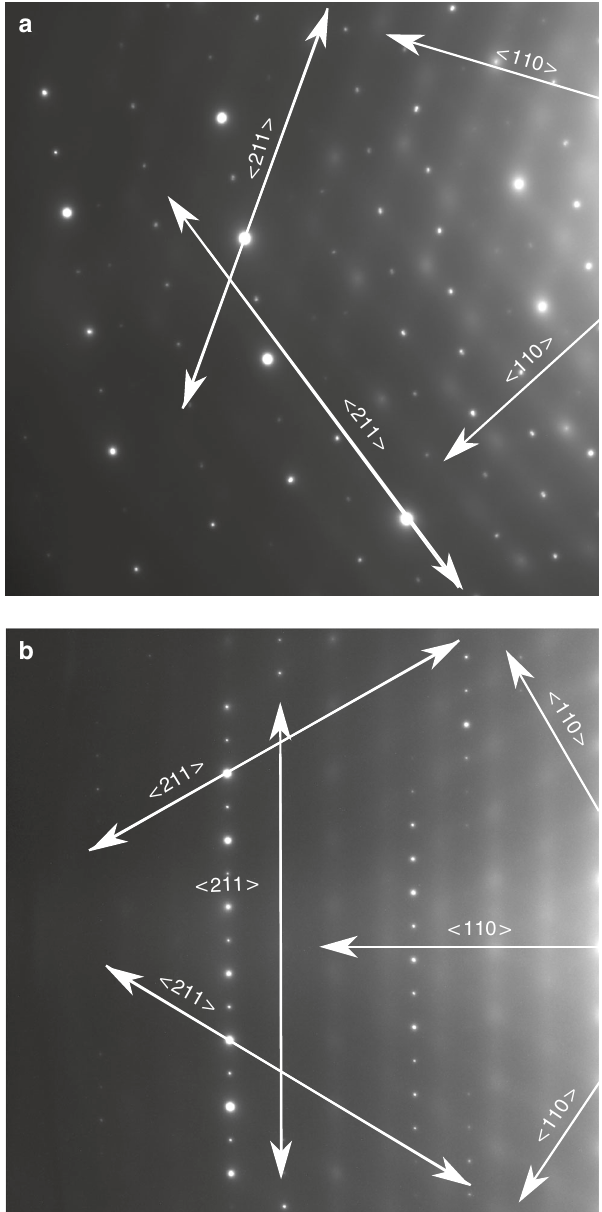
Fig. 2 Selected area electron diffraction displaying diffuse scattering for Pr 2 Zr 2 O 7 and Yb 2 Ti 2 O 7 . Single crystals oriented in the [111] direction for a